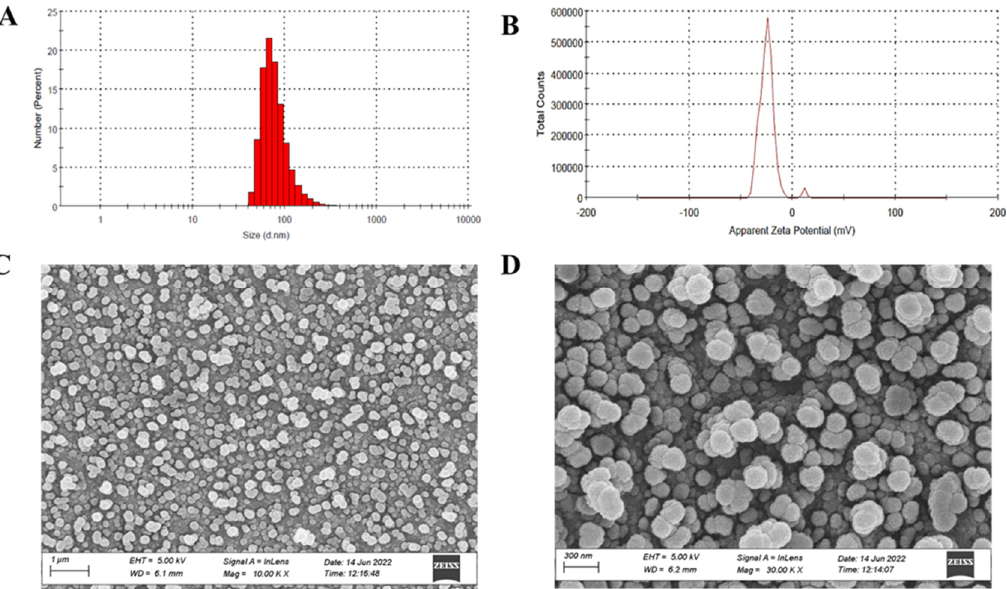
Figure 4. Characteristics of optimized PTH-LPs. ( A ) Particle size distribution, ( B ) Zeta potential, ( C , D ) Morphological assessment by Cryo-SEM. The data represent the means ± SD ( n = 3).